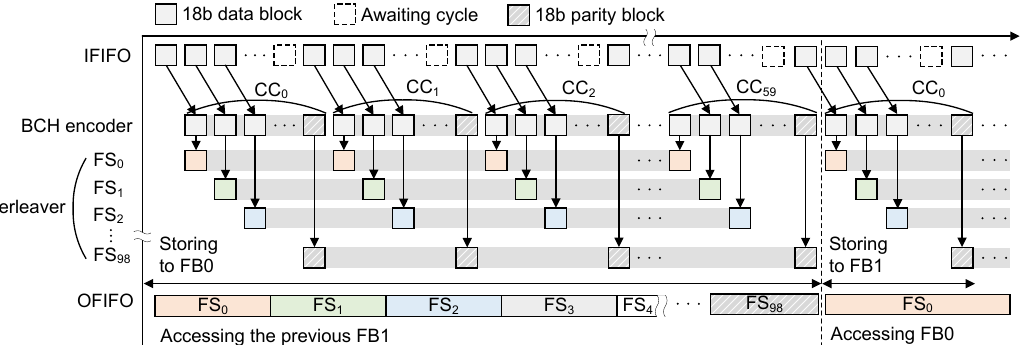
Figure 4. Proposed interleaving and buffering scheme for seamless data